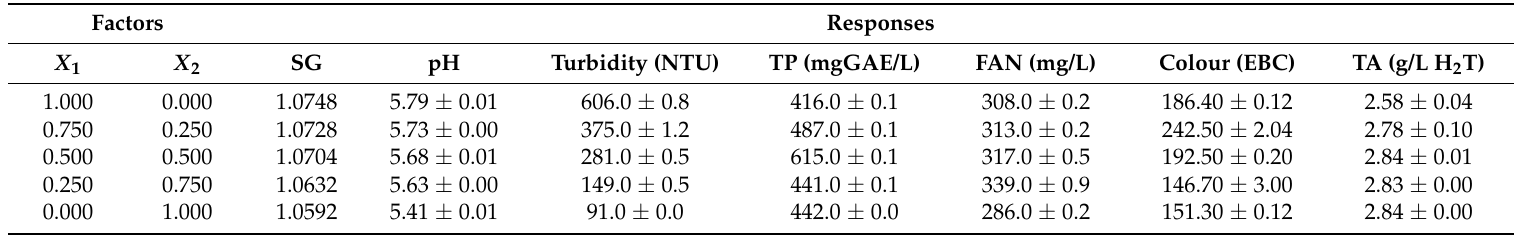
Table 5. Physicochemical characteristics of worts.